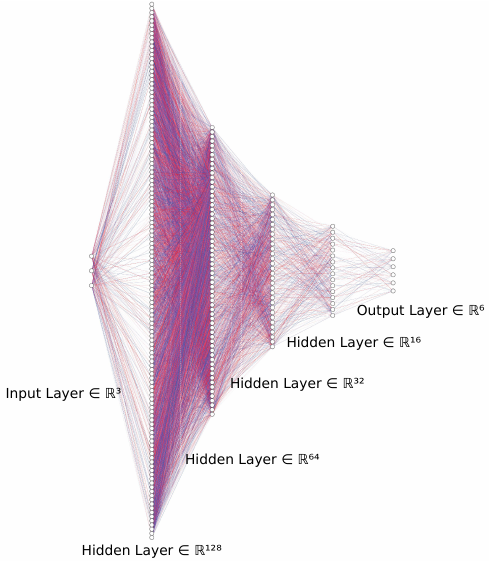
Figure 4. Improved artificial neural network model